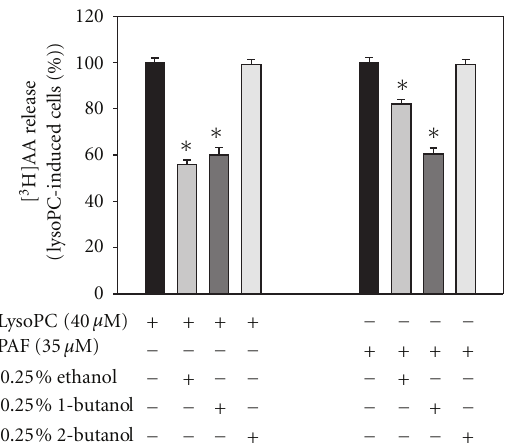
−− − − − − − − Figure 3: LysoPC- and PAF-mediated [ 3 H]AA release is inhibited by di ff erent alcohols. Prelabeled THP-1 cells were preincubated with di ff erent alcohols 30min before challenge with lysoPC (40 μ M, 10min) or PAF (35 μ M, 5min). [ 3 H]AA release in the medium was measured by liquid scintillation counting. Data are expressed as means ± SD of triplicate determinations within separate experi- ments. Asterisks indicate that values are statistically di ff erent from PAF- or lysoPC-treated cells ( ∗